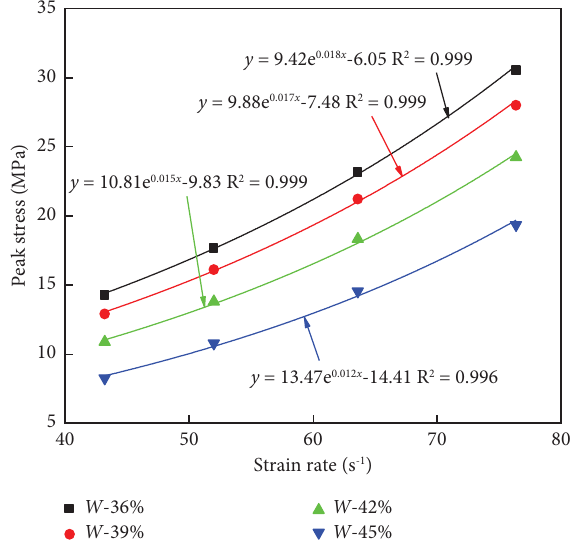
Figure 9: Relationship between the peak stress and strain rate of the composite specimen with medium thickness of